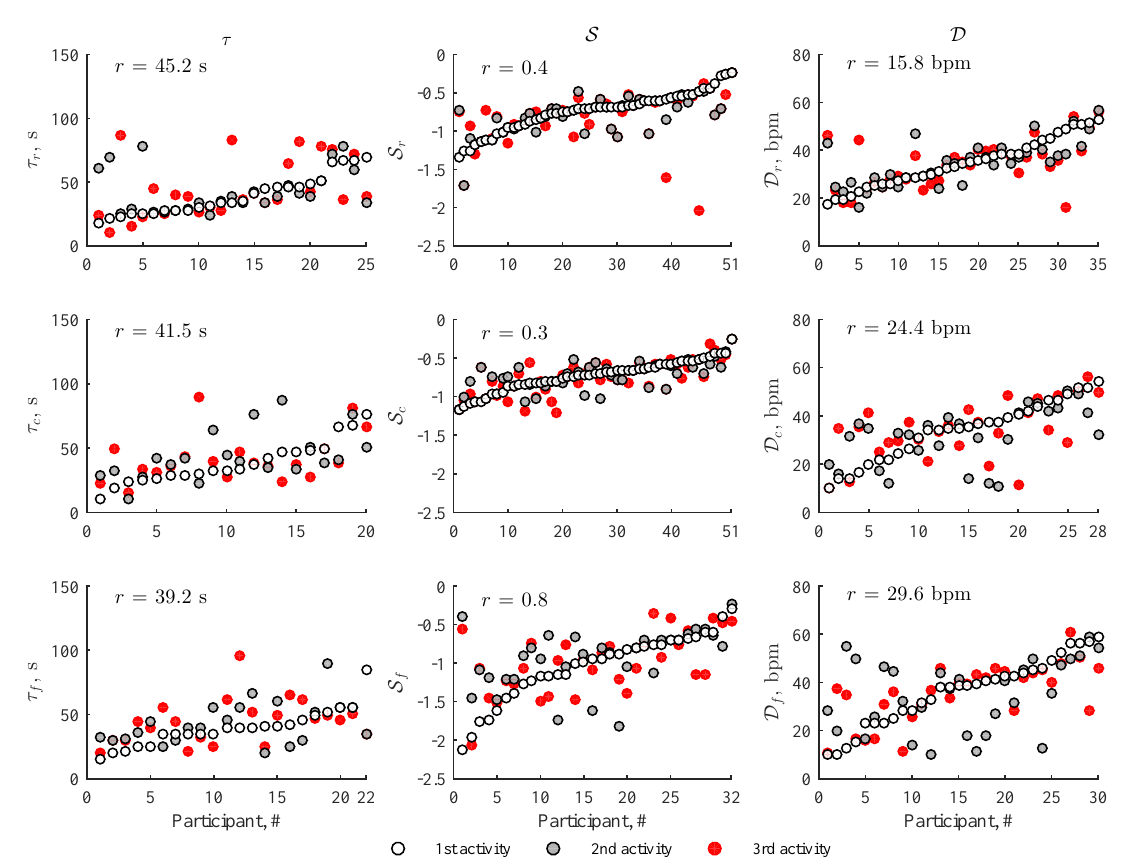
Figure 6. Repeatability of HRR parameters obtained for three consecutive stair climbing activities at a rate of 96 steps/min. The HRR parameter values are sorted with respect to the first stair climbing activity. Note that only those participants whose all three repeated stair climbing activities met the quality criterion of R 2 > 0.5 and had no corrupted segments were included in the repeatability